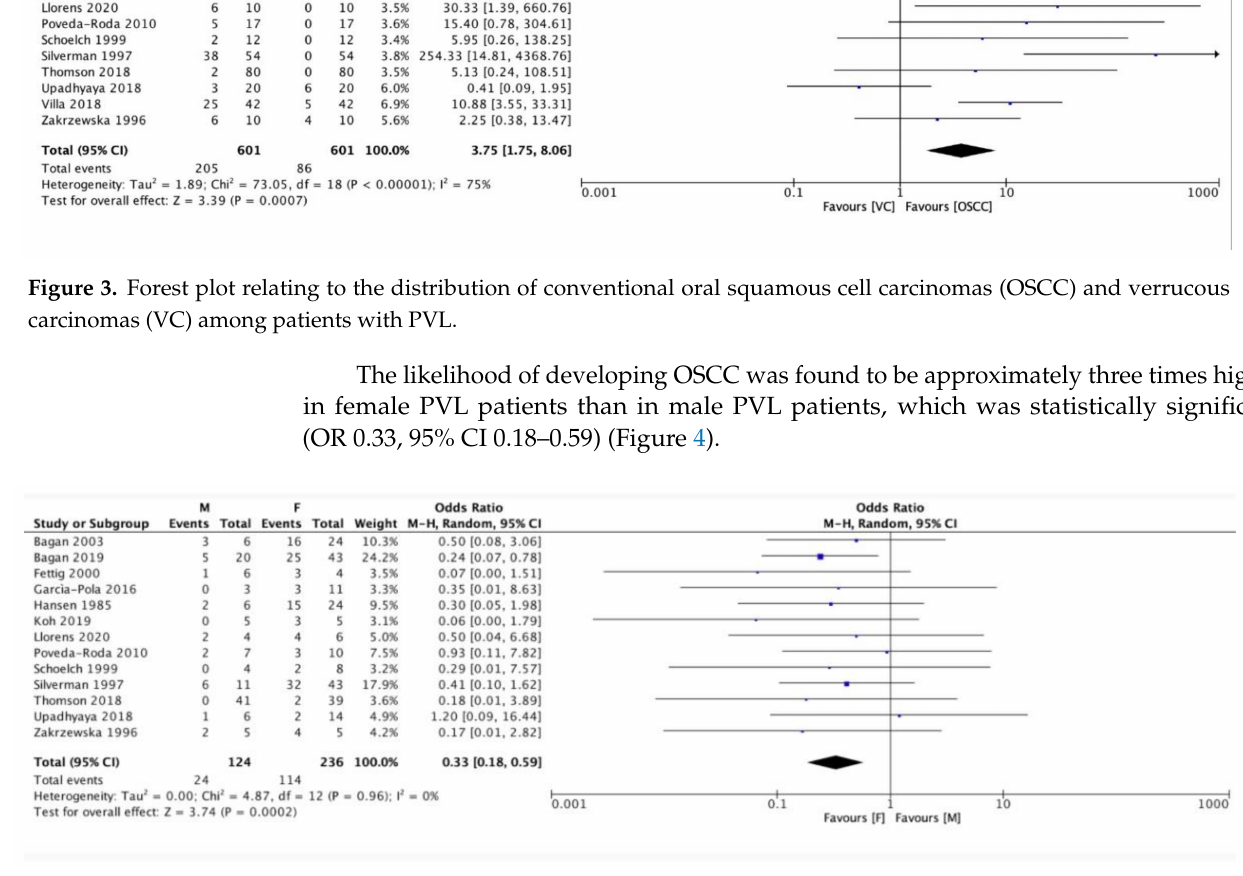
Figure 4. Forest plot relating to the distribution of conventional oral squamous cell carcinomas (OSCC) in male (M) and female (F) patients.